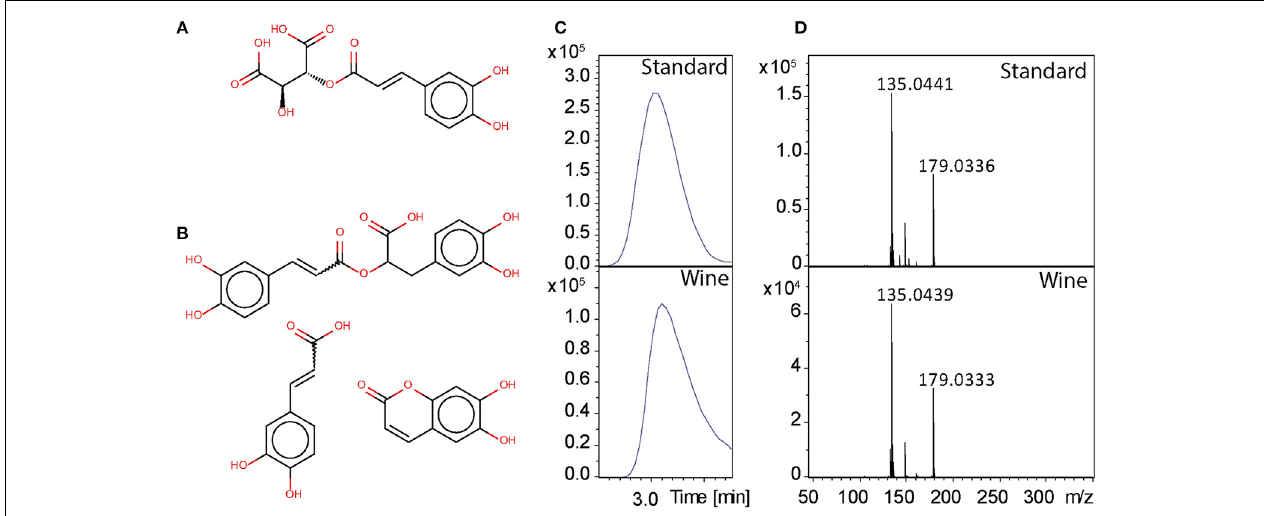
FIGURE 6 | (A) Caftaric acid, (B) structures with spectral similarities: rosmarinic acid, caffeic acid, and aesculetin. (C) Chromatographic peaks, (D) MS/MS spectra with data from the standard and from the wine.